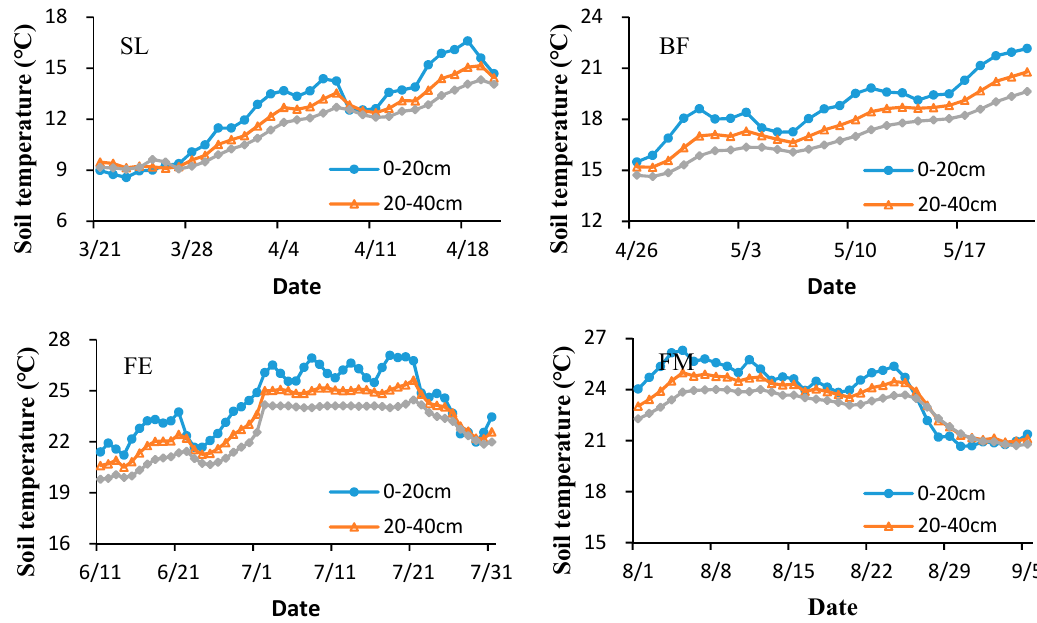
Figure 2. Soil temperatures during different phenological stages.